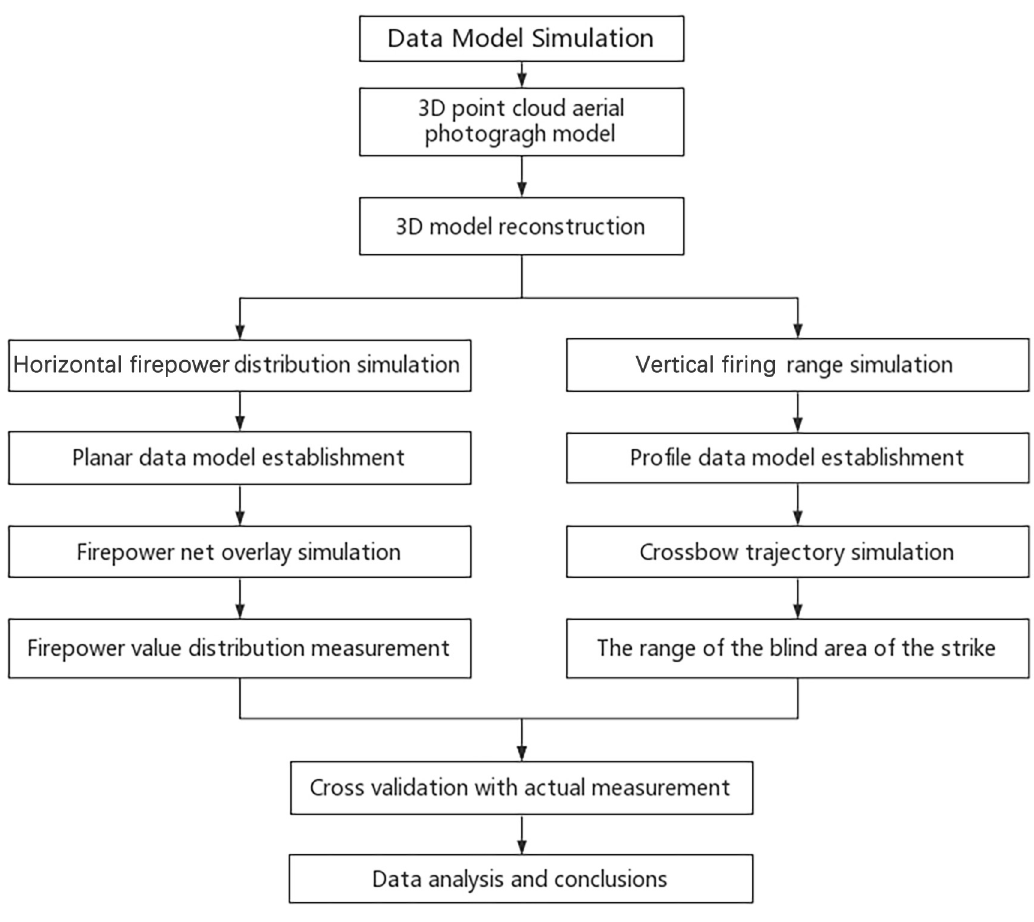
Fig 5. Research method and